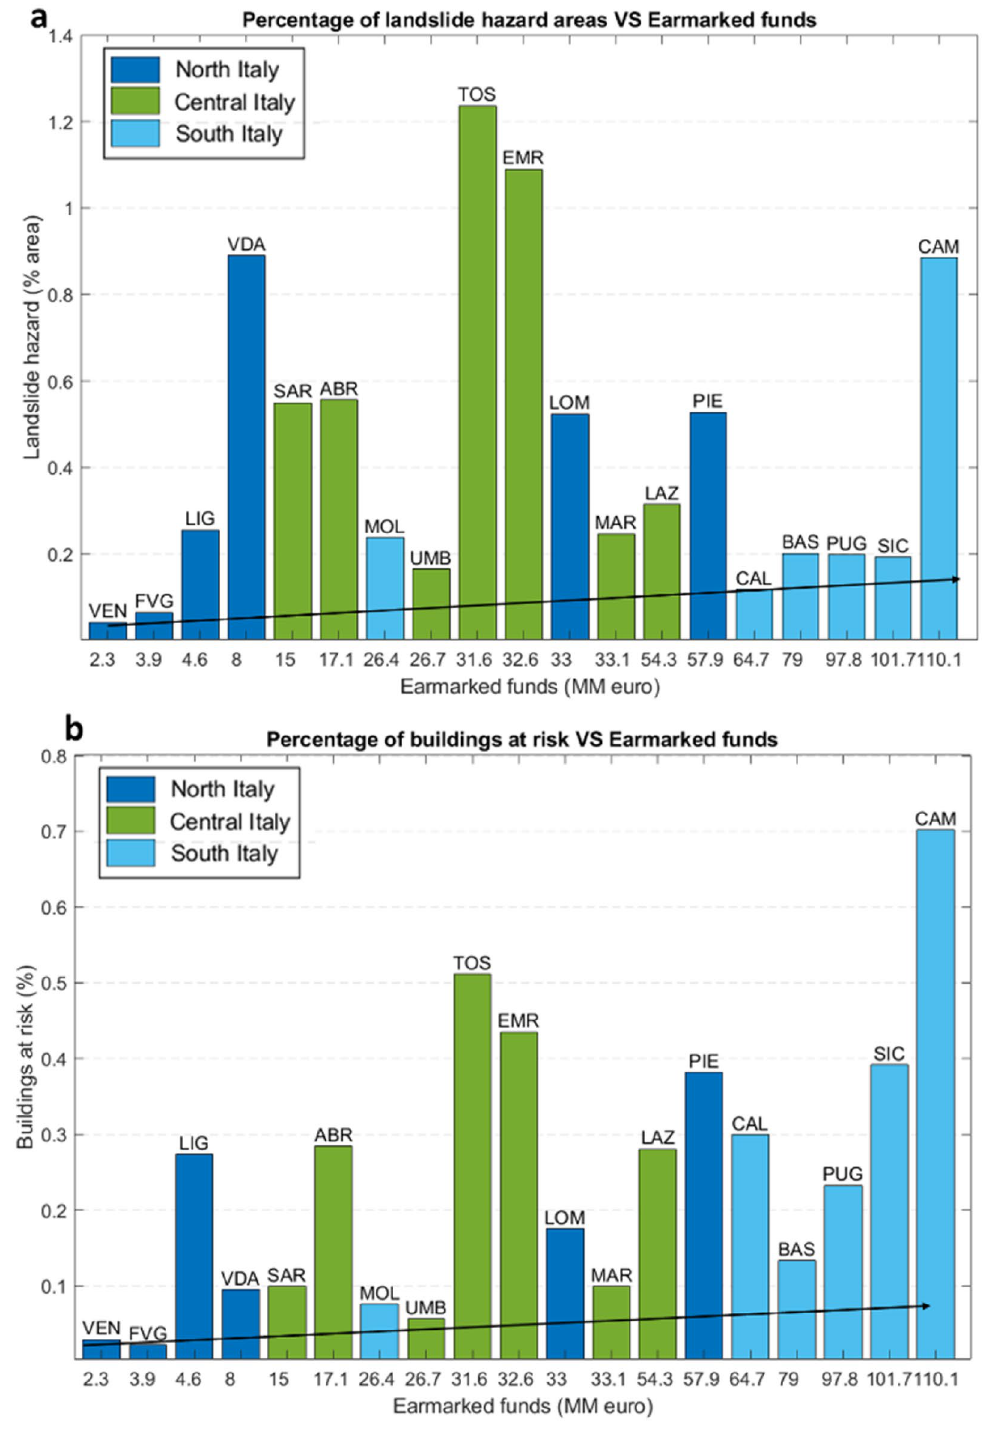
Figure 7. Validation data between earmarked funds in ( a ) with the percentage of landslide hazard areas for each region; in ( b ), the percentage of buildings at risk for each region. Each percentage was provided by ISPRA and normalized on the basis of regional size. ABR Abruzzo, BAS Basilicata, CAL Calabria, CAM Campania, EMR Emilia-Romagna, FVG Friuli-Venezia Giulia, LAZ Lazio, LIG Liguria, LOM Lombardy, MAR Marche, MOL Molise, PIE Piedmont, PUG Puglia, SAR Sardinia, SIC Sicily, TOS Tuscany, TAA Trentino-Alto Adige, UMB Umbria, VDA Valle d’Aosta, and VEN Veneto. The arrow indicates the increasing direction of allocated